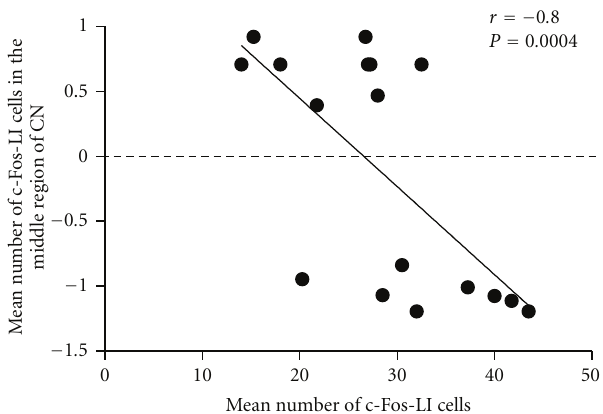
Figure 7: Histograms showing the mean number of c-Fos-LI cells in the middle region of the CN following electrical stimulation in control (a), presaline (b), pre-1% lido (c), and pre-5% lido (d) groups. Note that the mean numbers of c-Fos-LI cells in the pre- 1% lido and pre-5% lido groups were significantly less than that in 0 . 05 compared with the presaline group). the presaline group ( (cid:0) P (cid:0)